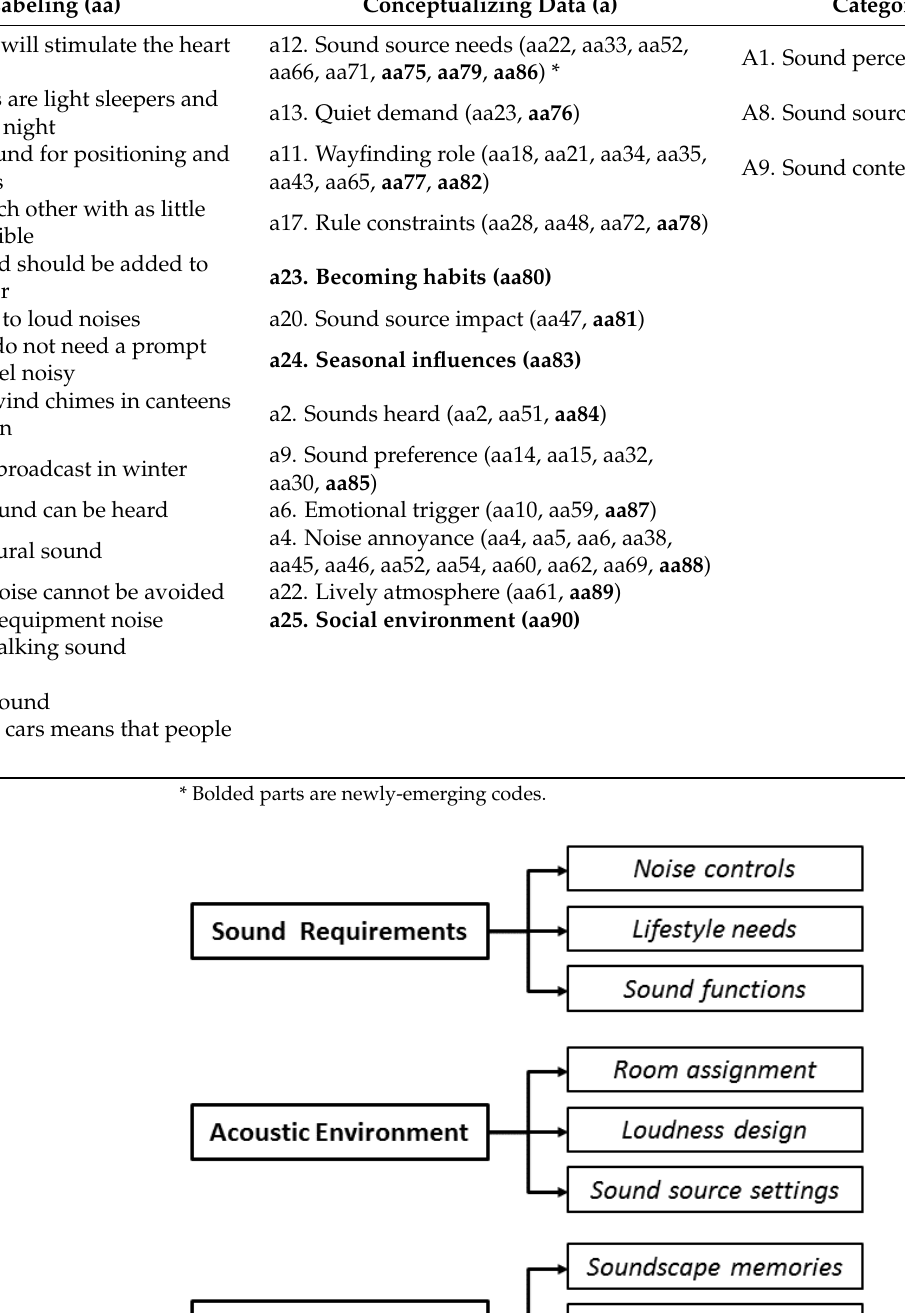
Table 3. Selective coding scheme of the sound perception.